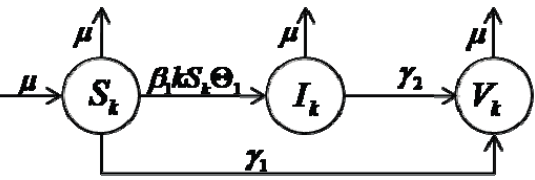
Figure 1. The transfer diagram